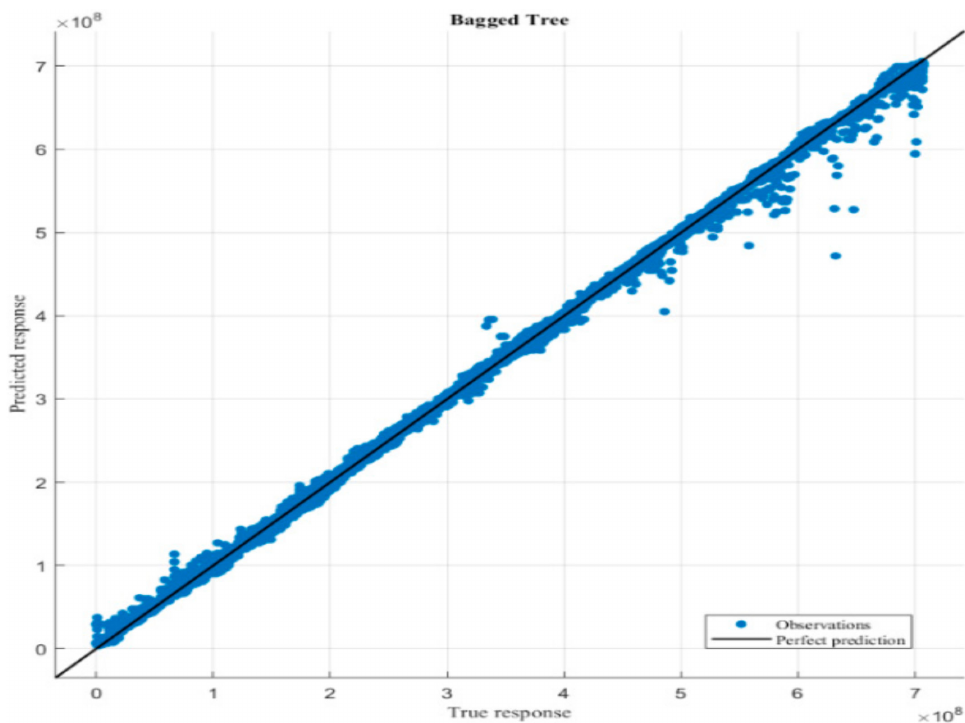
Figure 17. Bagged Trees Prediction vs. Actual training.